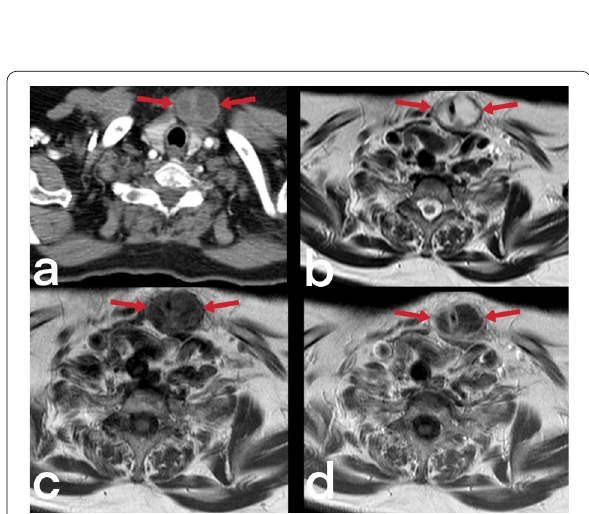
Fig. 15 Axial contrast-enhanced CT ( a ), axial T2 weighted ( b ), pre ( c ), and post-contrast T1 ( d ) weighted images of a 69-year-old female. Biloculated abscess formation is seen in the anterior left paramedian region of the neck, which shows peripheral enhancement